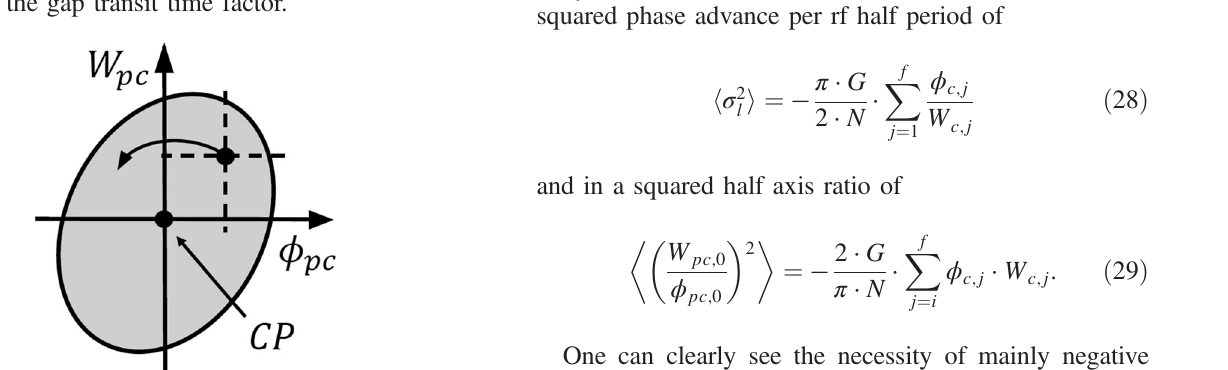
T T denotes the gap transit time factor.